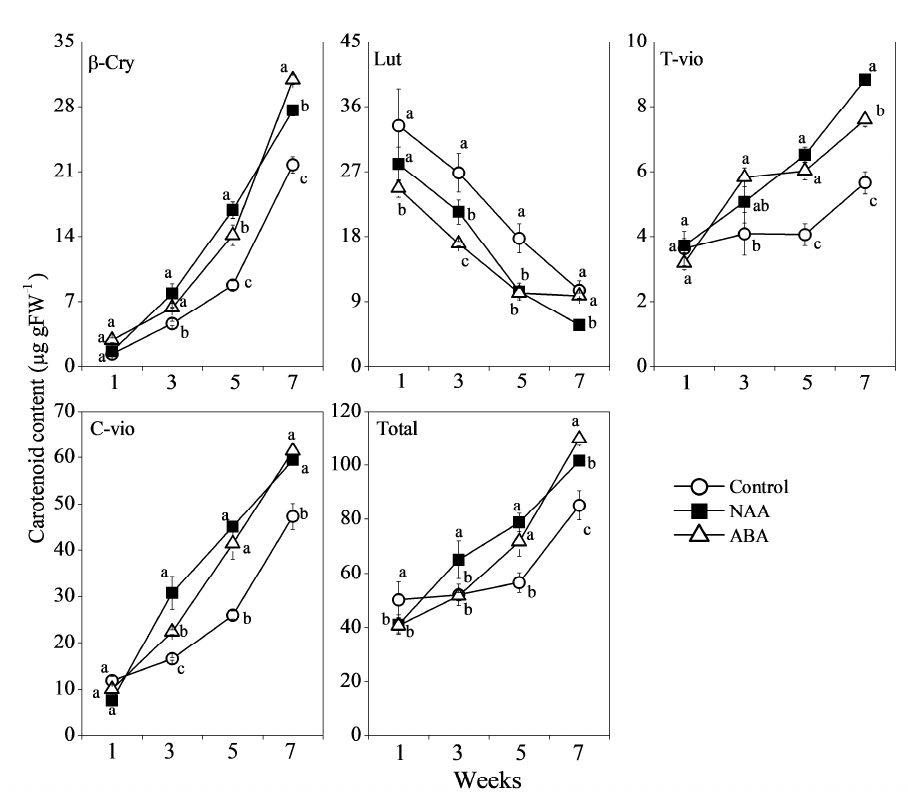
Figure 6. Effect of NAA and ABA on carotenoid content in the flavedo of GA and PDJ-treated citrus fruit. β -Cry, β -cryptoxanthin; Lut, lutein; T-vio, all- trans -violaxanthin; C-vio, 9- cis -violaxanthin; Total, total carotenoid. The value for total carotenoid was the sum of identified carotenoids. The results shown are the mean ± SE for triplicate samples. Different letters (a, b, and c) indicate significant differences at the 5% level by Tukey’s test.